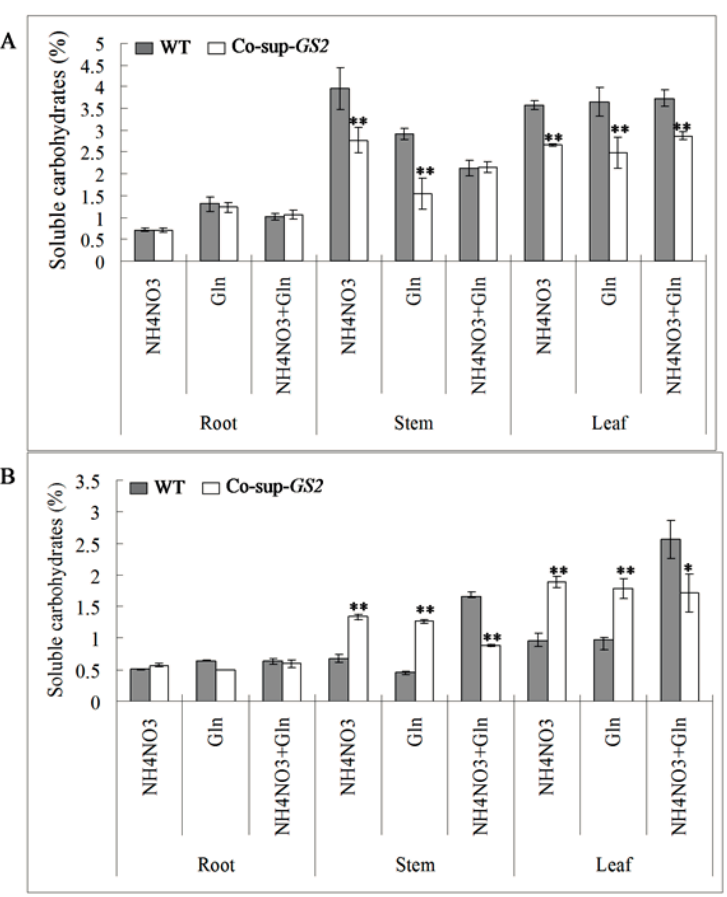
Figure 4. The concentration of soluble carbohydrates in the roots, stems and uppermost leaves of GS2 -cosuppressed plants (Co-sup- GS2 ) and wild-type plants (WT) at the seedling stage ( A ) and the tillering stage ( B ) under N (NH 4 NO 3 ), G (Gln) and N + G (NH 4 NO 3 + Gln) conditions. Values are the mean ± SD from three biological replicated plant materials. p = 0.01,